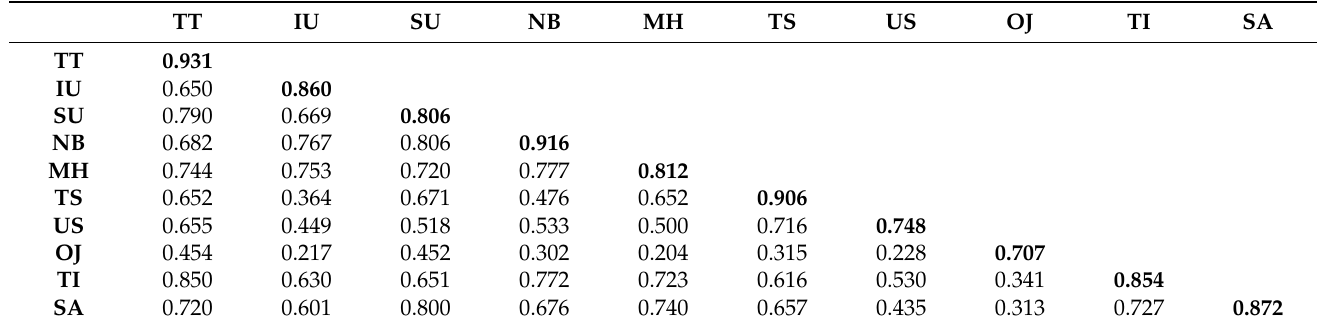
Table 4. Discriminant validity.